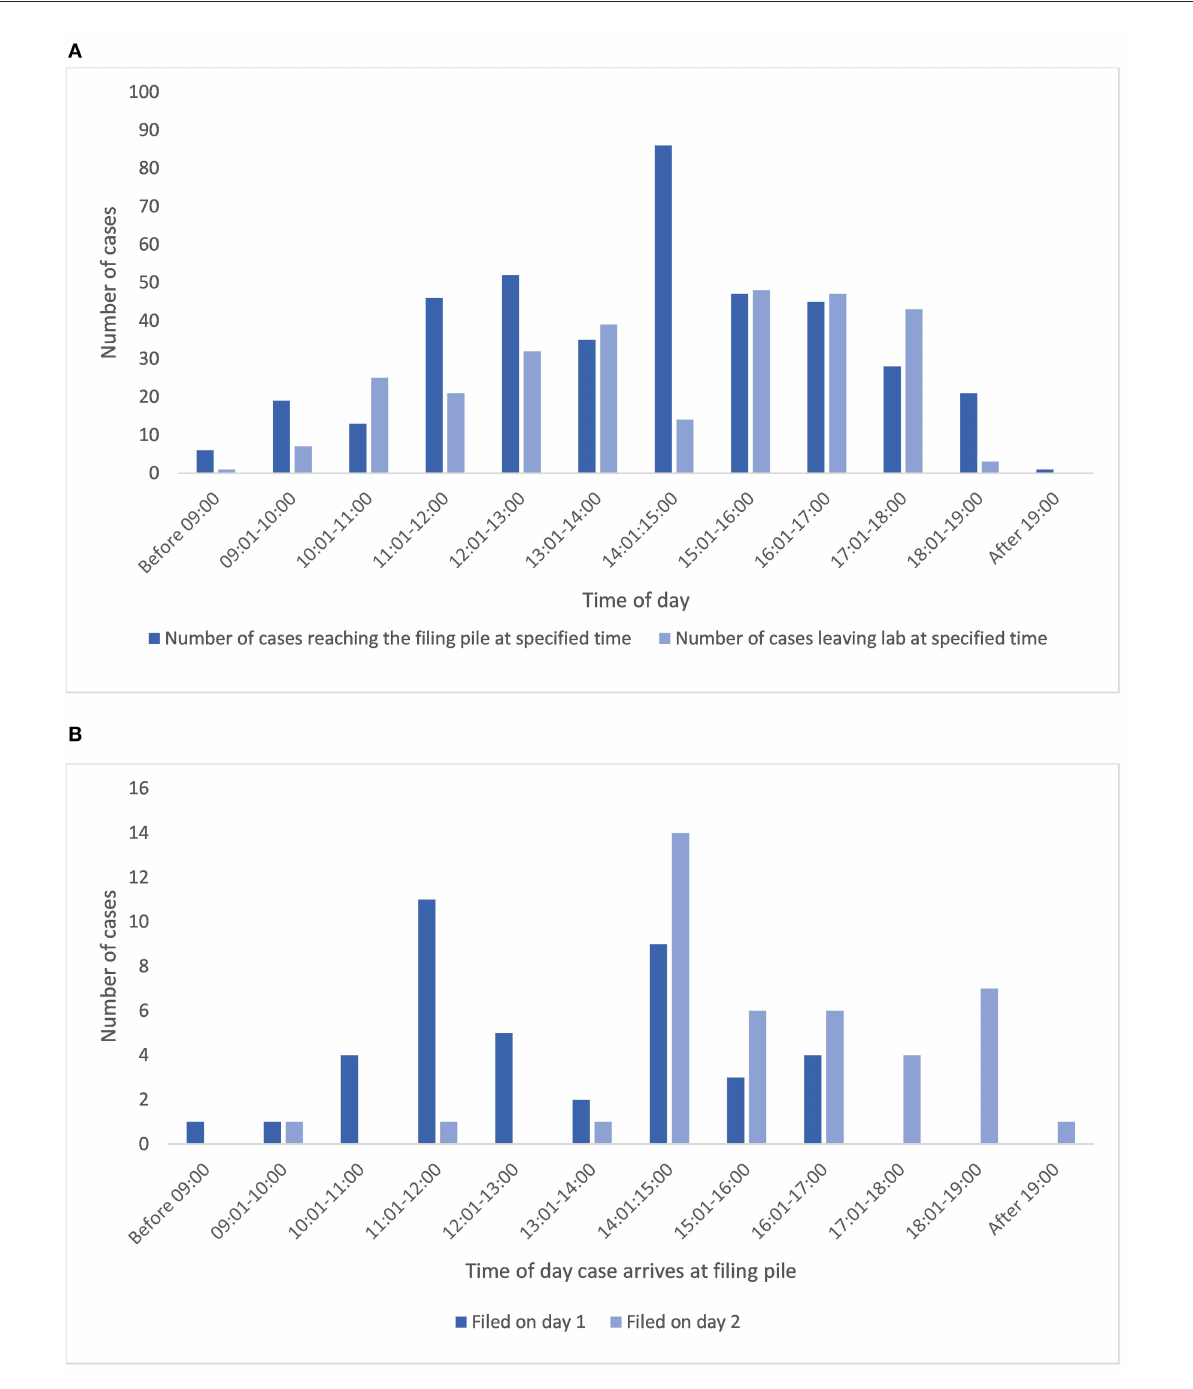
upon the time that a case is returned for filing. Figure 6B illustrates the data related to this activity for traces which also included a pathologist and that were filed on day 1 or 2 after